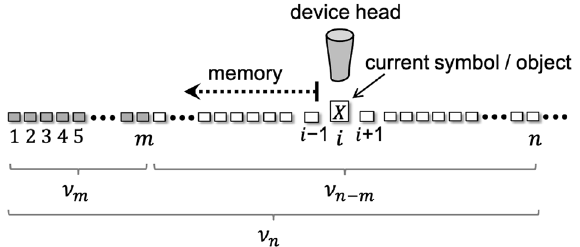
Figure 1. Sketch of the chain-like system, which represents a segment of a tape with a finite number of cells. At each computation step, i , a machine working on the tape follows instructions from a program, transition table or polymer template, considers the symbols already incorporated (from 1 to i − 1 ) and its ‘head’ changes the value of the current cell. The segment sequence, ν n , is divided into an initial sequence ν m and a remainder sequence ν n − m . The remainder segment may be initially inexistent or with a null sequence (meaningless values for the cells from m + 1 to n